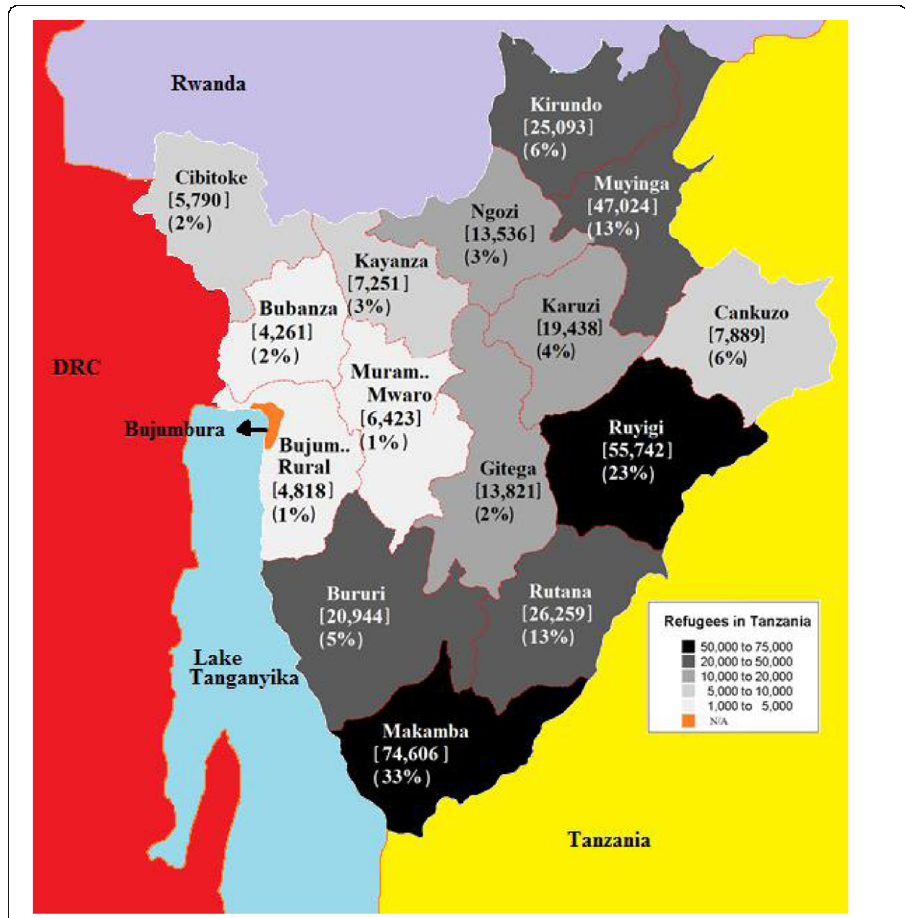
Fig. 3 Number of refugees in Tanzania per province of origin [brackets] and as a share of the province ’